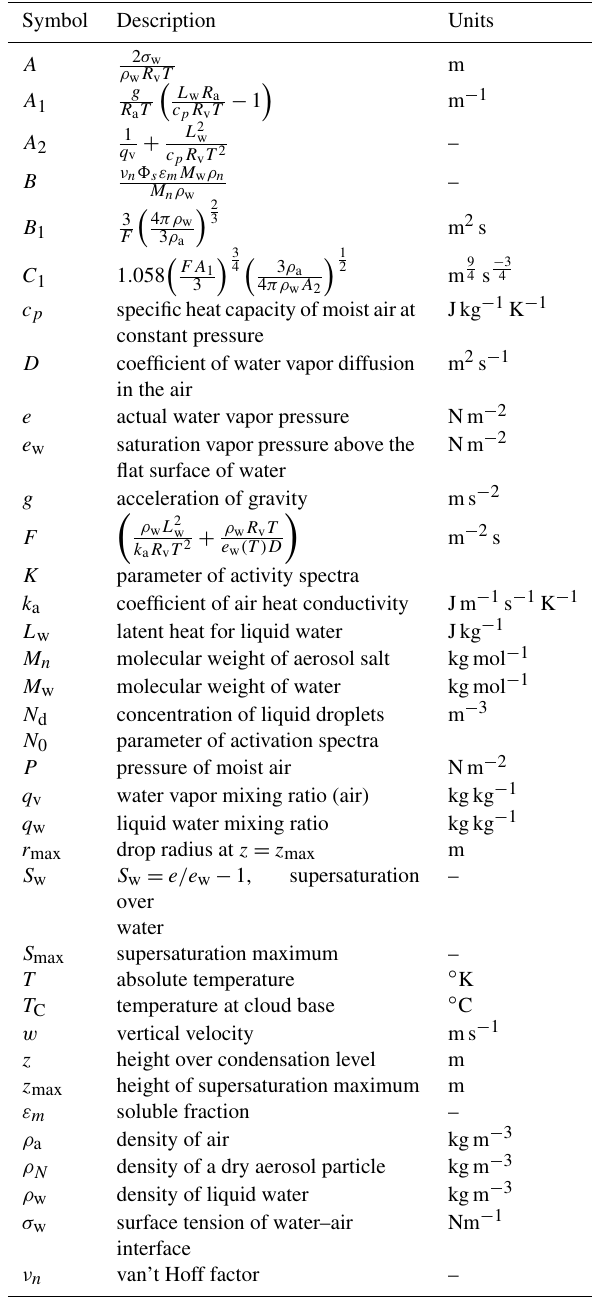
Table 1. List of